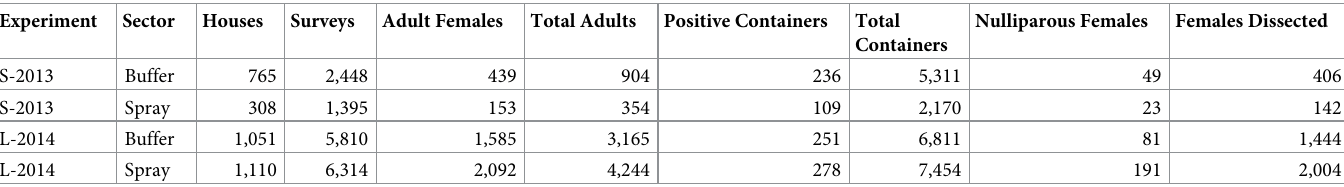
Table 1. Summary of Aedes aegypti collected in 2013 and 2014 experiments evaluating ultra-low-volume space sprays in Iquitos, Peru. Observation counts include houses, surveys (cid:3) , sampled adult mosquitoes, sampled containers, and adult female dissections (cid:3)(cid:3) (parity). Experiment